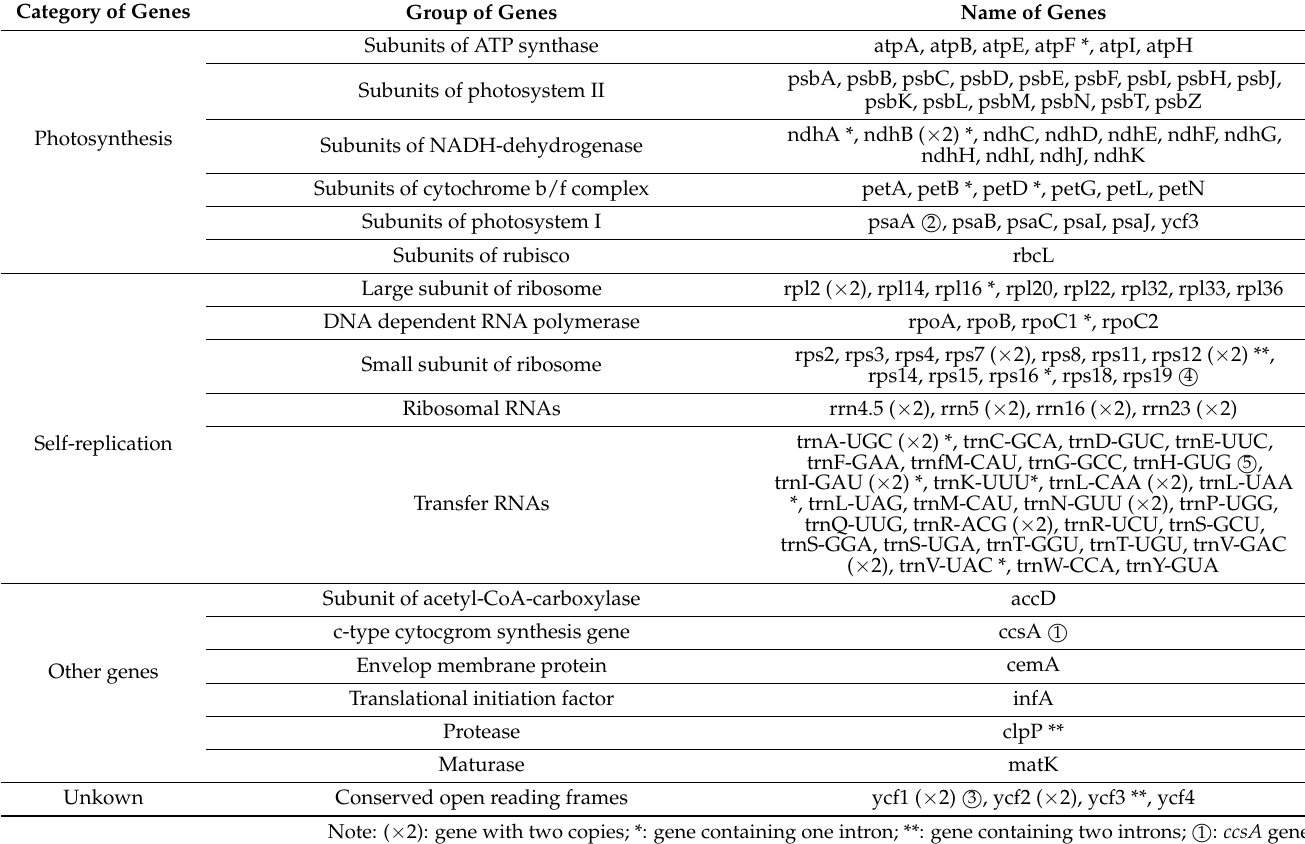
Table 2. Genes present in the 12 sequenced chloroplast genomes in Dianthus